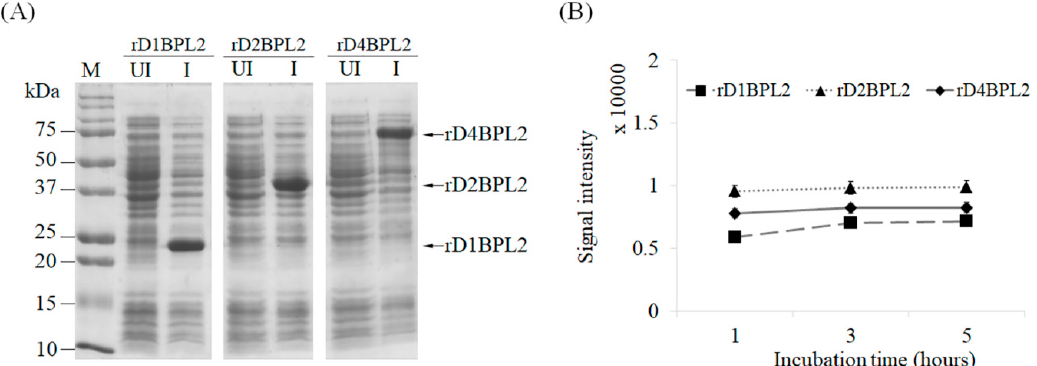
Figure 3. Expression of rBPL2 (Recombinant Bryopsis plumosa lectin 2). rD1BPL2 (monomeric), rD2BPL2 (dimeric), and rD4BPL2 (tetrameric) expressed in E. coli BL21 ( λ DE3). ( A ) M, Molecular weight marker; UI, uninduced lysate; I, induction with isopropyl β -D-1-thiogalactopyranoside (IPTG) for 5 h. Arrows indicate target proteins. ( B ) Expression level of recombinant proteins at different induction times. Squares, rD1BPL2; triangles, rD2BPL2; diamonds, rD4BPL2.